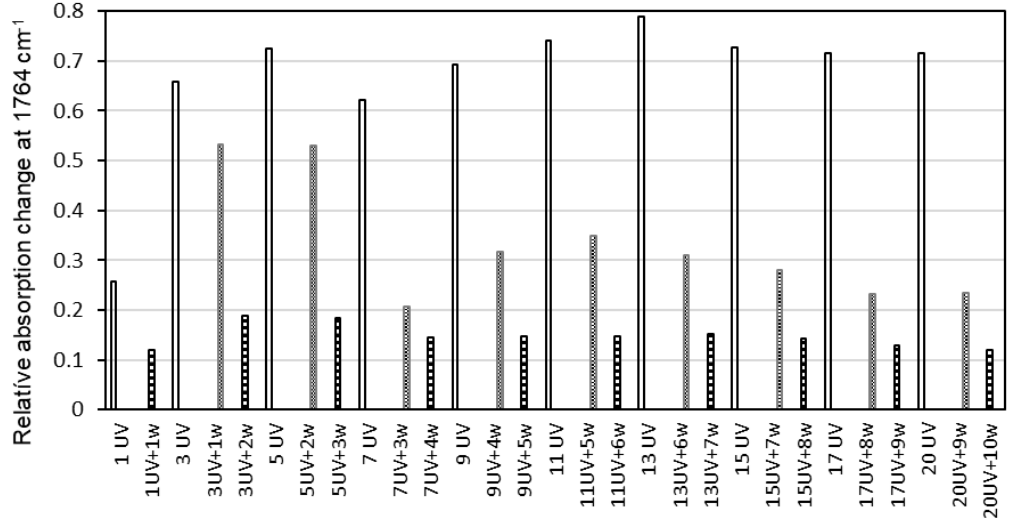
Figure 9. Absorption change of the unconjugated carbonyls at 1764 cm − 1 for Scots pine. Empty columns show the effect of pure UV irradiation. xUV = x-day UV irradiation; xUV + yw is an abbreviation where x is the extent of UV irradiation, and y is the extent of water leaching in days.